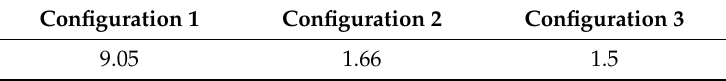
Figure 6. Expected energy not supplied (EENS) under different system configurations. Table 1. Total EENS (MWh) calculated for different system configurations.